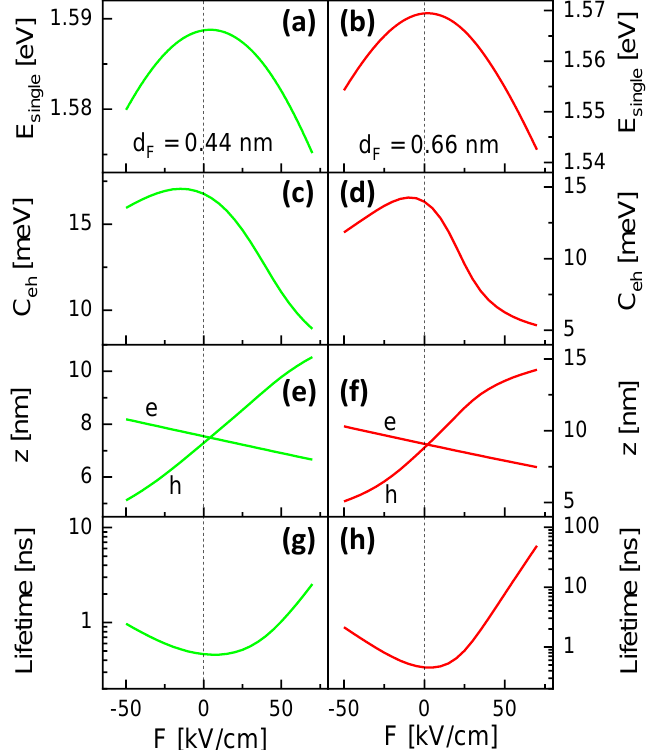
Figure 5. ( a , b ) Simulated single-particle energy E single ; ( c , d ) Coulomb interaction energy C eh ; ( e , f ) z positions of the electron (e) and hole (h) wave-function center of mass relative to the tip of the CSQS; and ( g , h ) radiative exciton lifetime τ X for CSQSs with d F = 0.44 nm and 0.66 nm (QD1) as a function of F